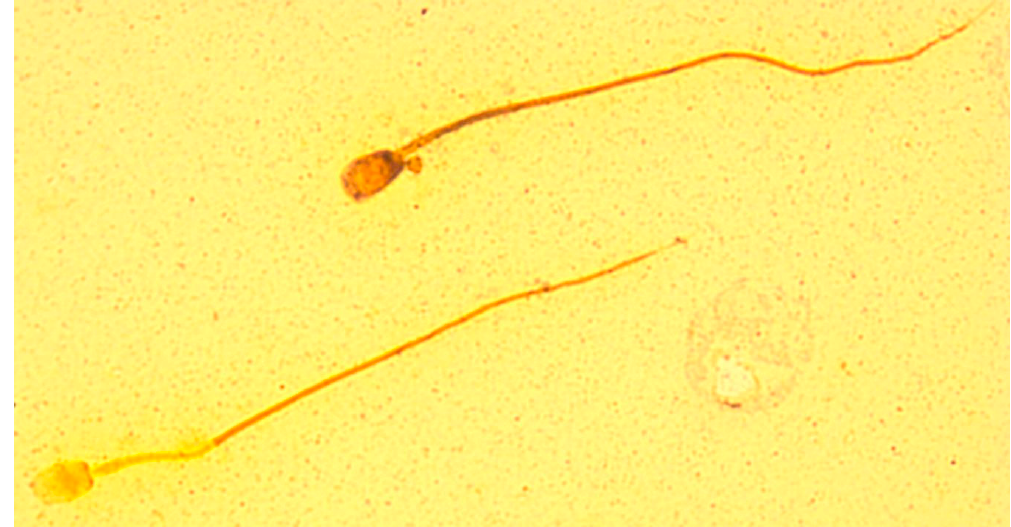
Figure 2. Spermatozoa of silver fox—silver nitrate staining revealing individual sperm structures.